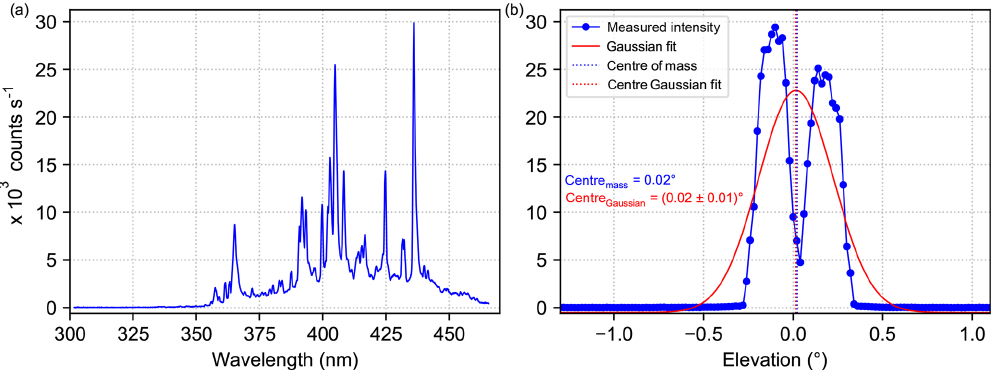
Figure 4. (a) Xenon lamp spectrum recorded on 13 September 2016 by the MPIC instrument. The three distinct emission lines at 365.16, 404.90 and 435.96nm, which are used for the analysis, are clearly visible. (b) Intensity curve at 435.96nm (blue solid line) recorded on 13 September by the MPIC instrument. The obtained centre of mass is indicated by the dashed blue line. Further, the centre obtained by a Gaussian fit and the corresponding fit are displayed in red.